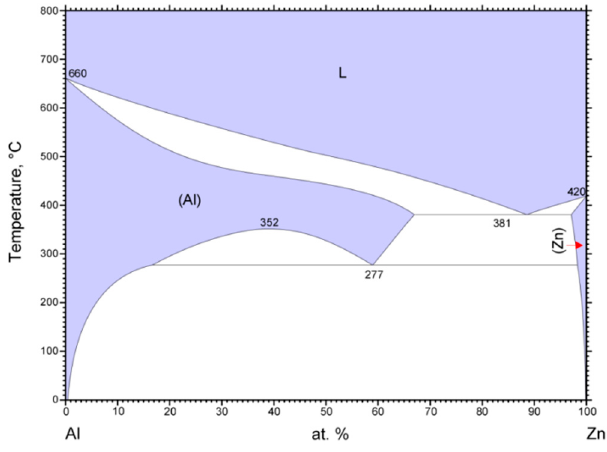
Figure 9. Phase diagram of Zn–Al [22].